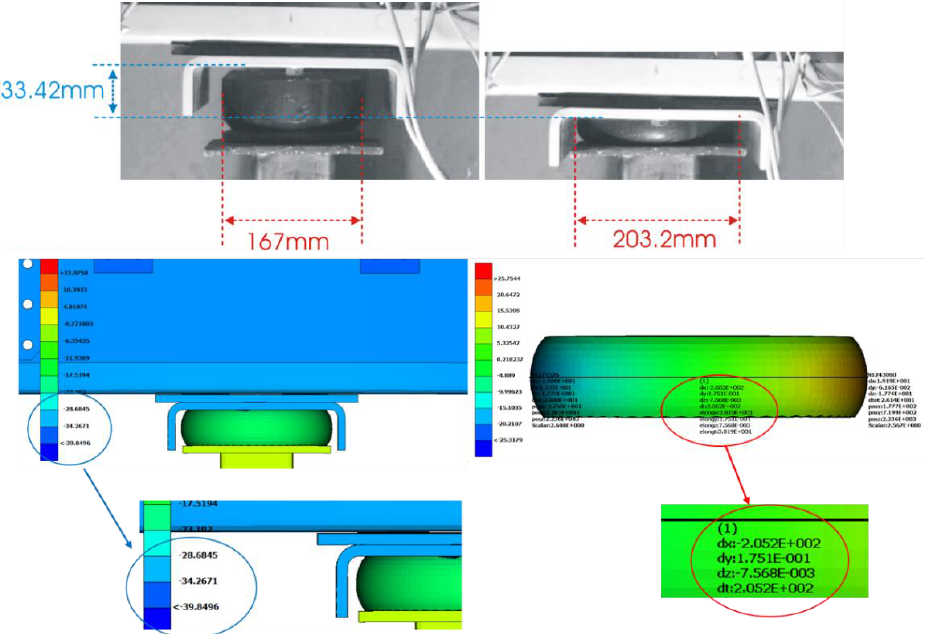
Figure 9. Detailed comparison of the lateral and vertical deformation results at maximum displace- ment between numerical analysis and experimental measurements.